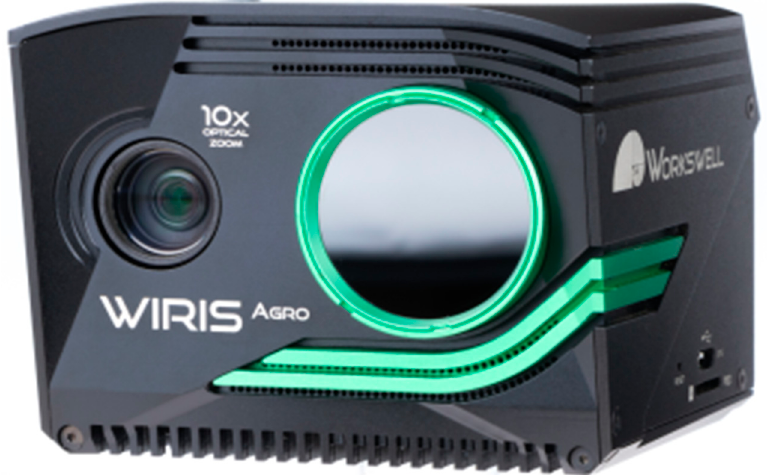
Figure 1. The WORKSWELL WIRIS AGRO R INFRARED CWSI CAMERA.